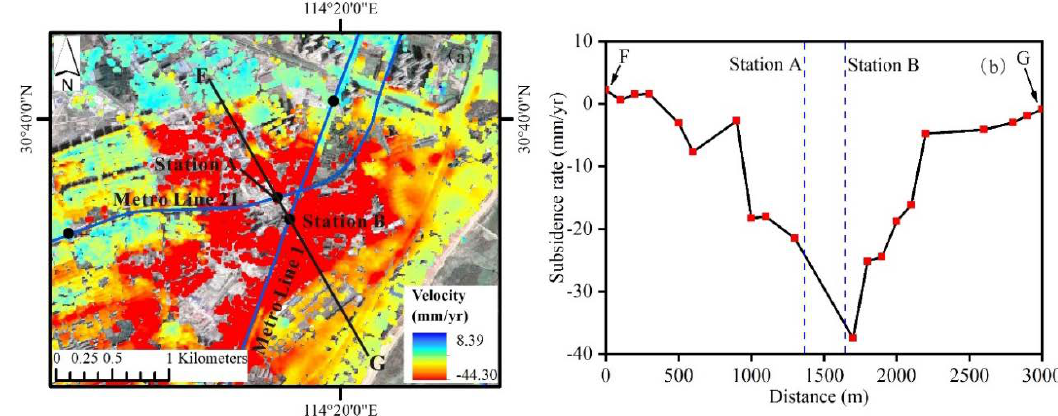
Figure 10. Maps show subsidence rate in Region 1 ( a ), and a subsidence profile passing through stations A and B ( b ).